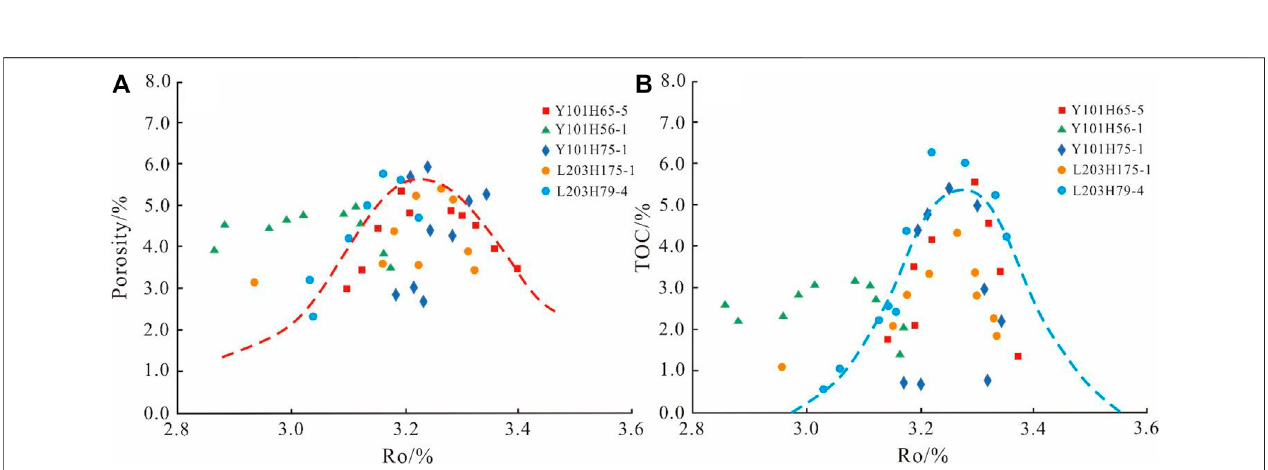
FIGURE11| EvolutionofshaleorganicmatterintheLongmaxiFormationoftheLuzhouarea. (A) .RelationshipbetweenR O andporosity; (B) .Relationshipbetween R O and